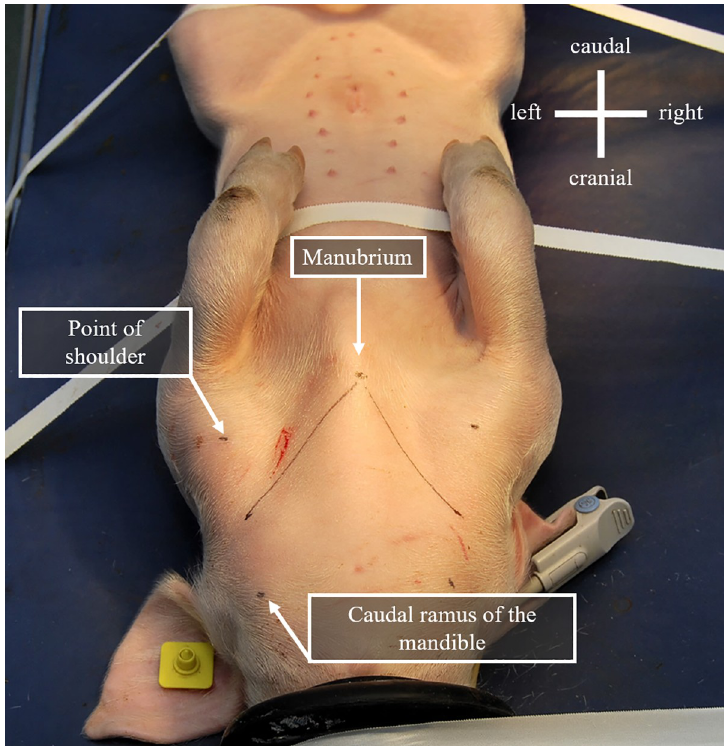
Fig 1. Landmarks for the determination of the expected passage of the external jugular vein in 21 days old piglet.